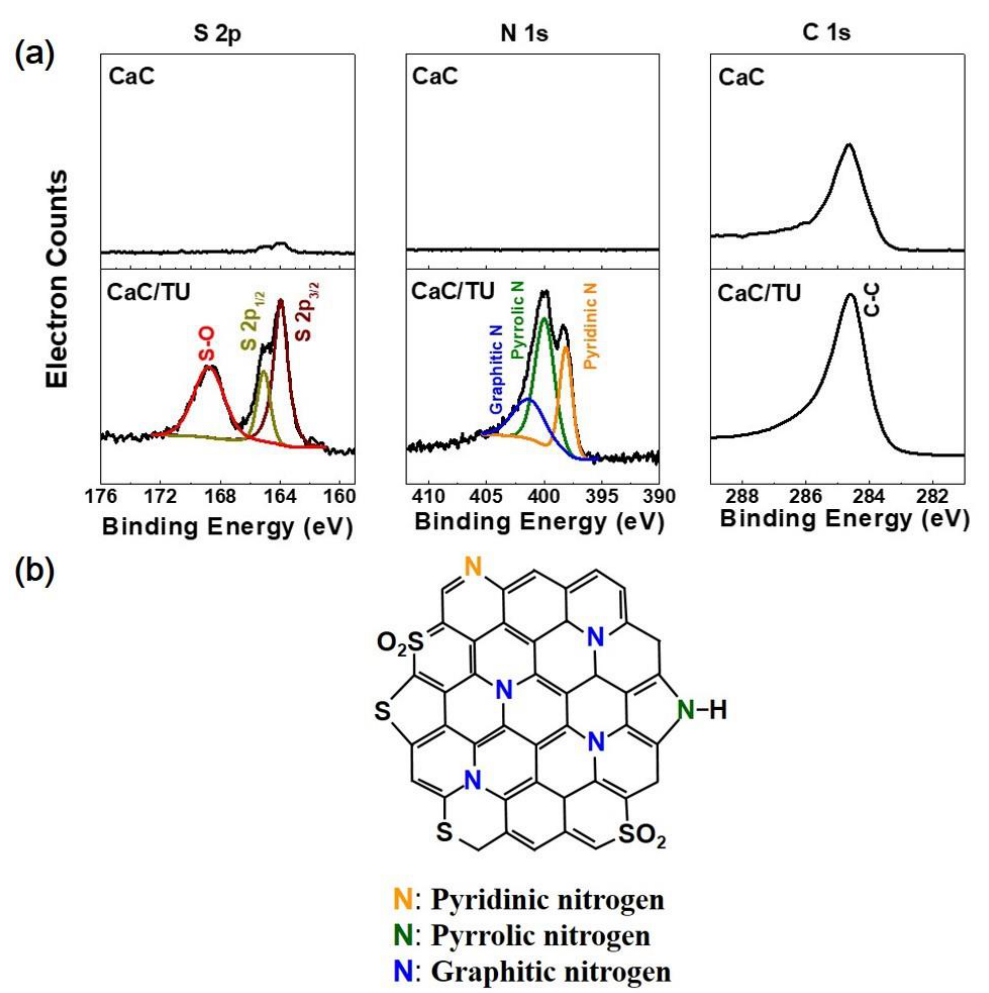
Figure 4. ( a ) XPS spectra of the CaC and CaC / TU powders. ( b ) Schematic for the formation of N- and S-doped mesoporous carbon via reaction between calcium citrate and thiourea.